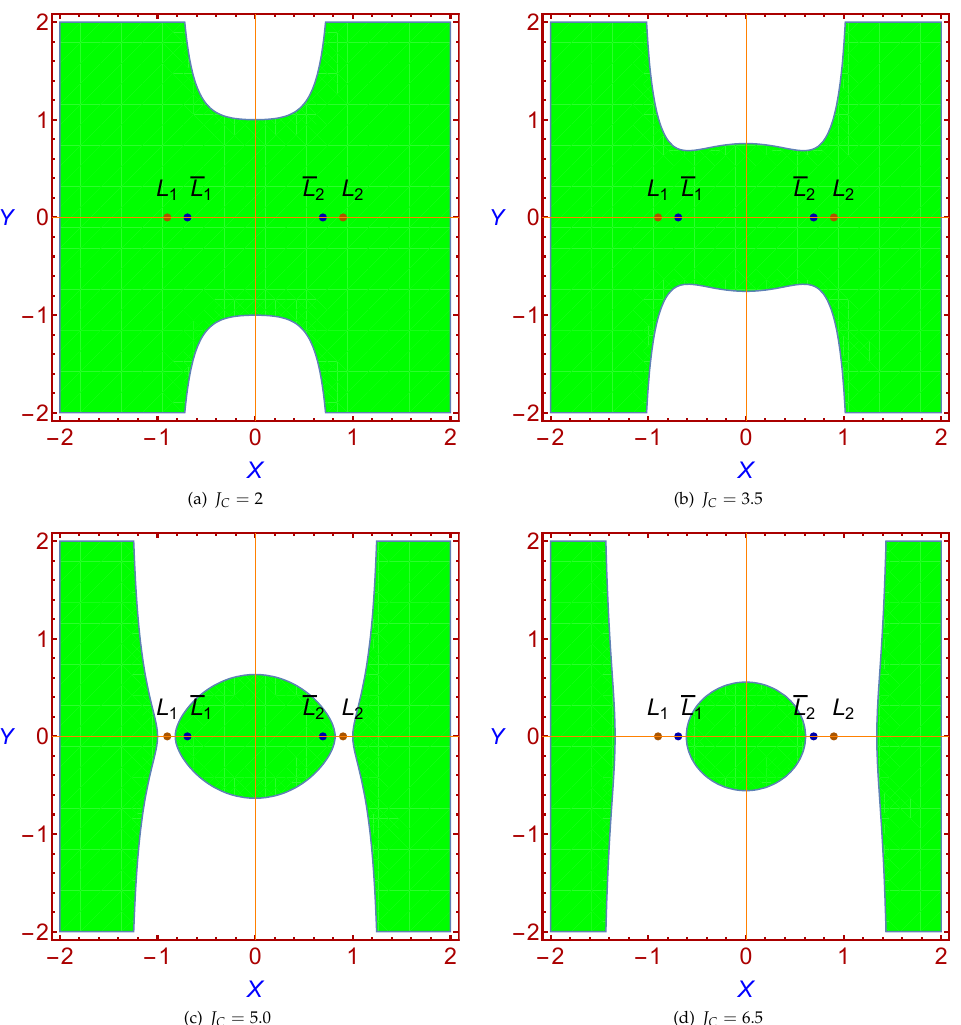
Figure 2. Regions of allowed (green area) and forbidden (white area)